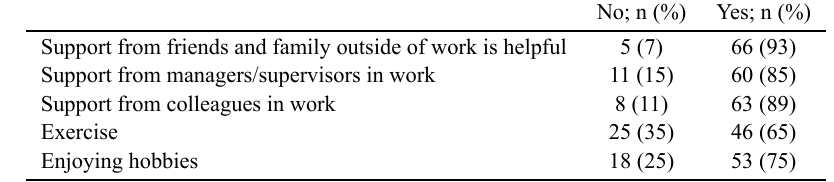
Table 7. Whether support and activity helped staff to cope; frequencies and